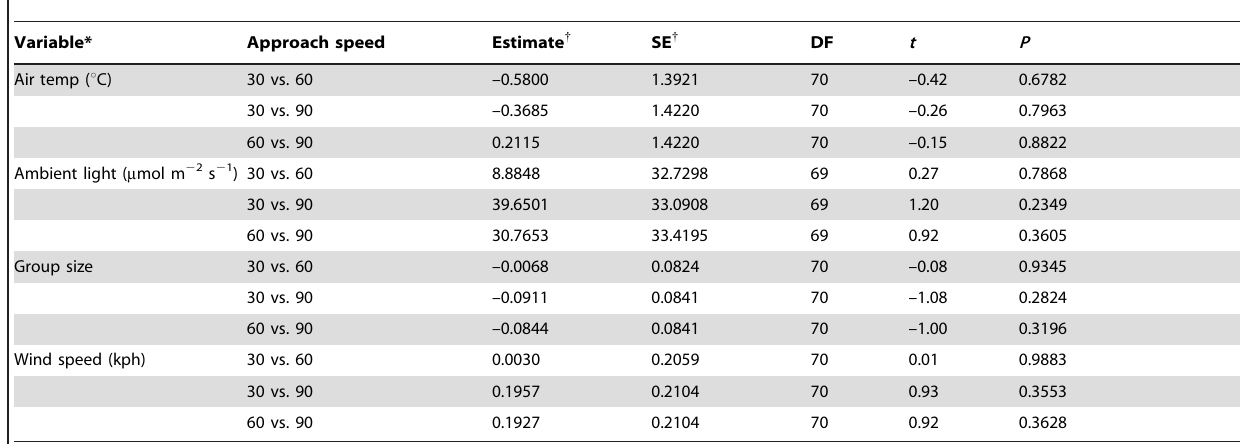
Table 1. Differences in least squares means associated with a mixed linear model comparison of variables measured during responses by free-ranging turkey vultures exposed to the approach of a Ford F250 pickup truck from a standard 1.13-km distance at 30 kph (n = 25 approaches), 60 kph (n = 25 approaches, but only 24 considered because of a missing value), or 90 kph (n = 23 approaches).